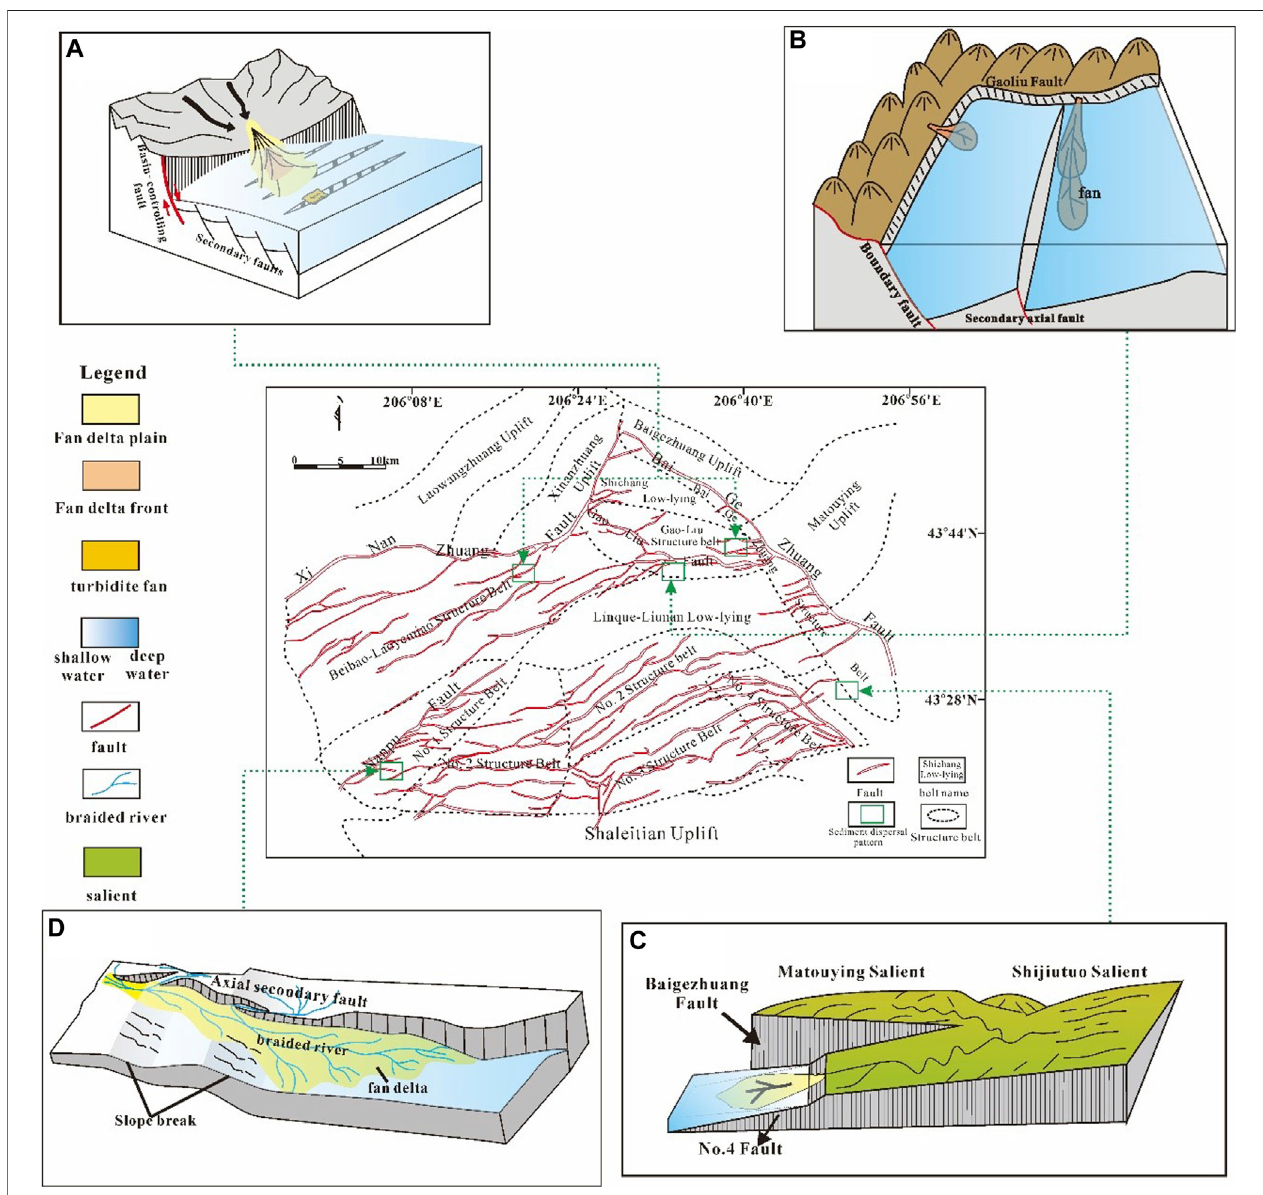
FIGURE8| Schematicdiagramofthedifferentsedimentsdispersalpatternof (A) segmentalpoint+multi-stagebrokenslope, (B) single-stagebrokenslope+axial rift valley, (C) axial broken slope, (D) paleo-slope + axial rift valley in Nanpu Sag.